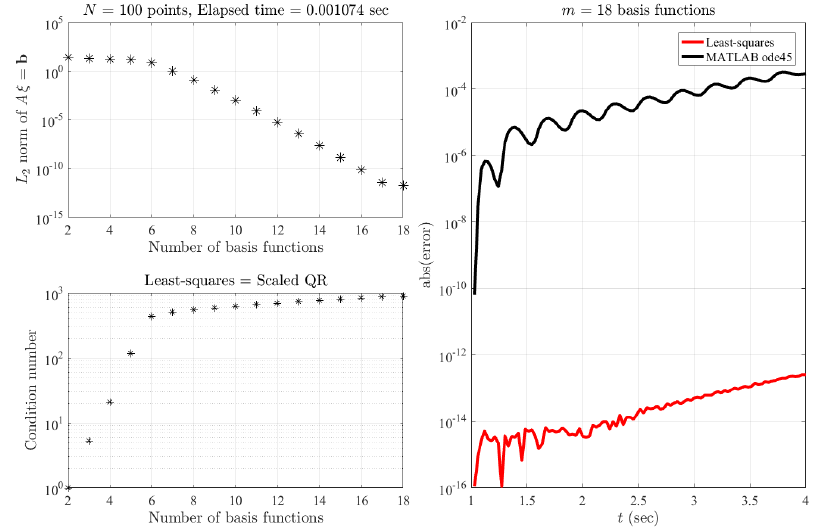
Figure 1. Results of example with known solution ( m = 18 and N =